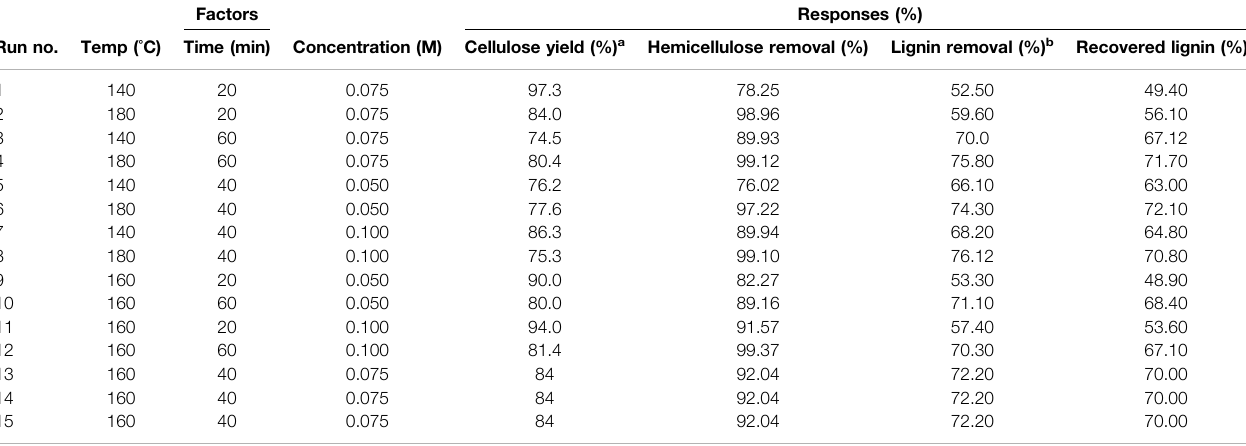
TABLE 1 | Effect of reaction factors on solid composition of solvothermal fractionation for lignin extraction using the response surface method (RSM). Factors Responses